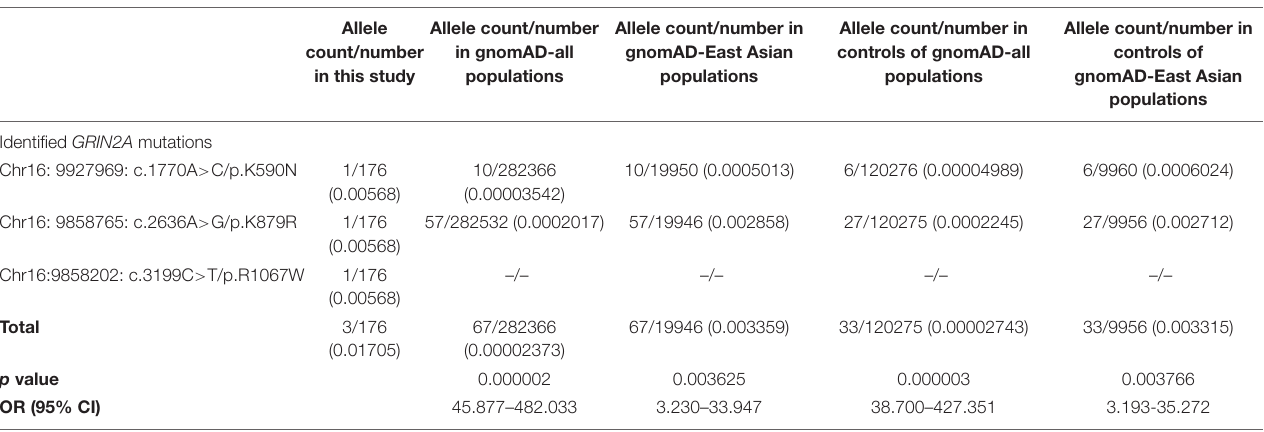
TABLE 2 | Gene-based burden analysis for GRIN2A mutations identified in this